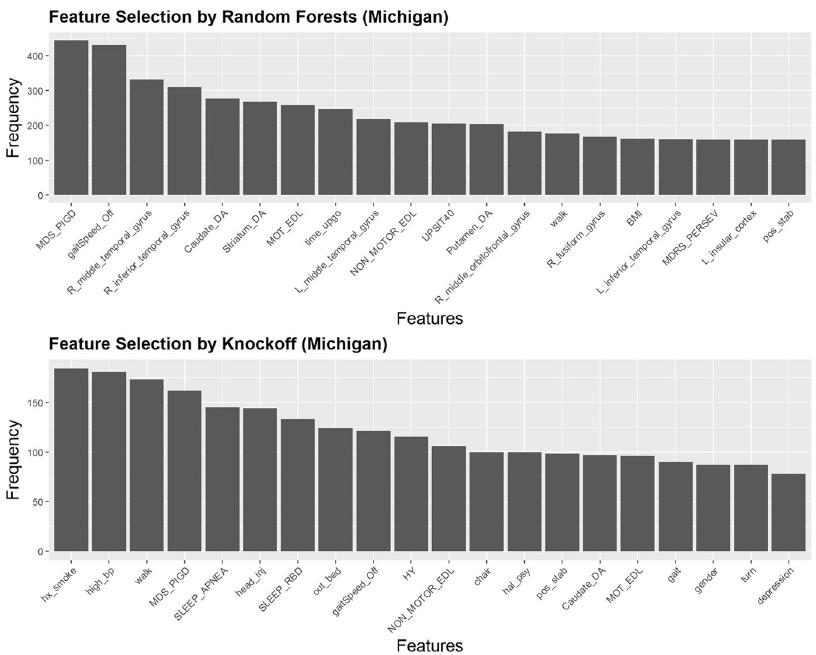
Figure 8. Results of feature selection for the Michigan dataset using random forest (top) and knockoff filtering (bottom). The barplots present the exact number of times the top listed features are